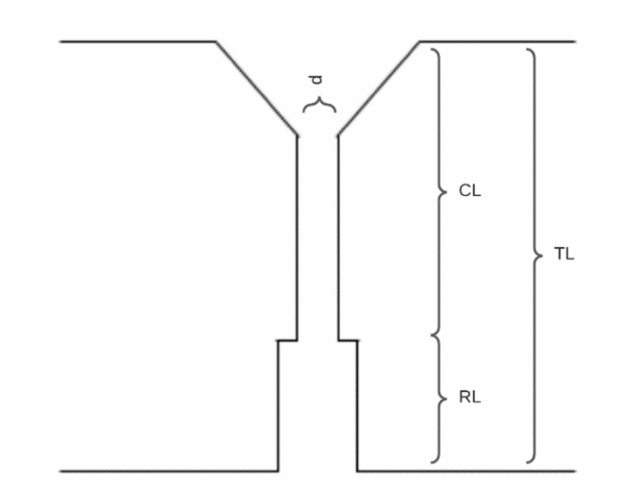
Figure 4. Diagram of the die hole and the relationship between the elements for calculating the Compression Rate (CR), where d is the diameter, CL is the compression length, RL is the relief length and TL is the total length. following relations between the elements presented in the scheme: CR = CL + RL and CR = CL/d